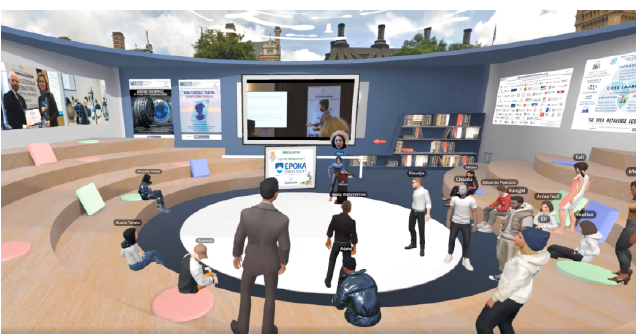
Figure 19: BBA Metaverse Headquarters, hosting Epoka University